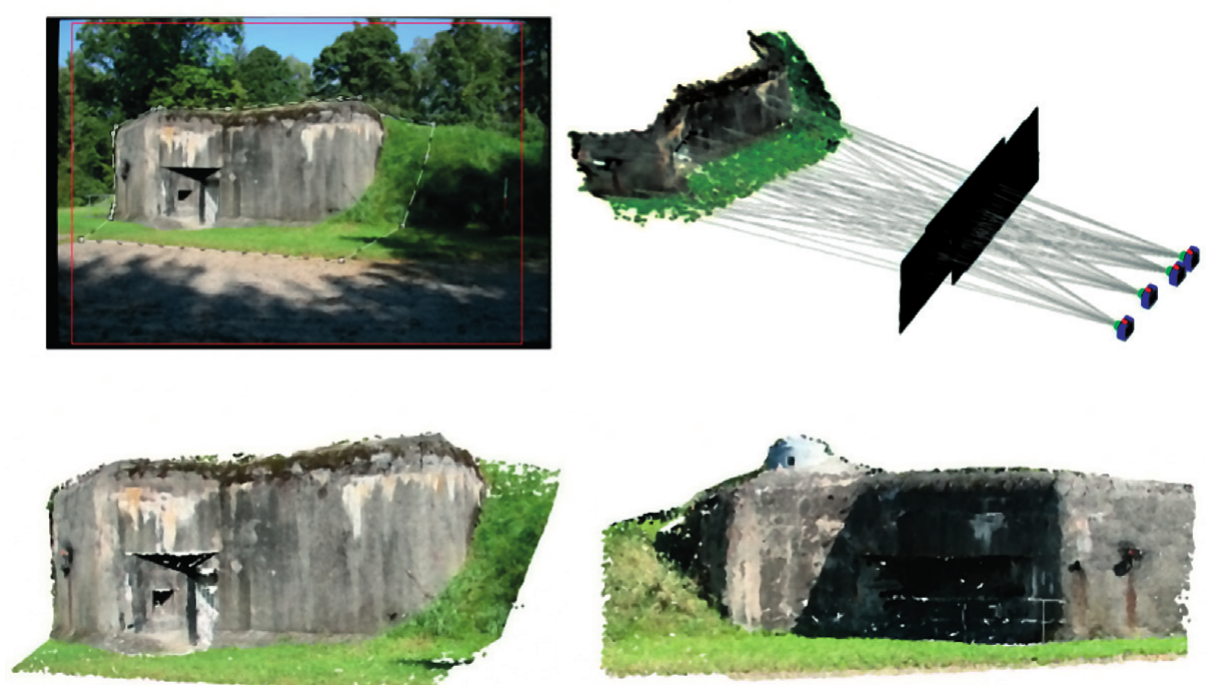
Fig. 6. From left to right: an idealized point field image, camera positions and the point cloud